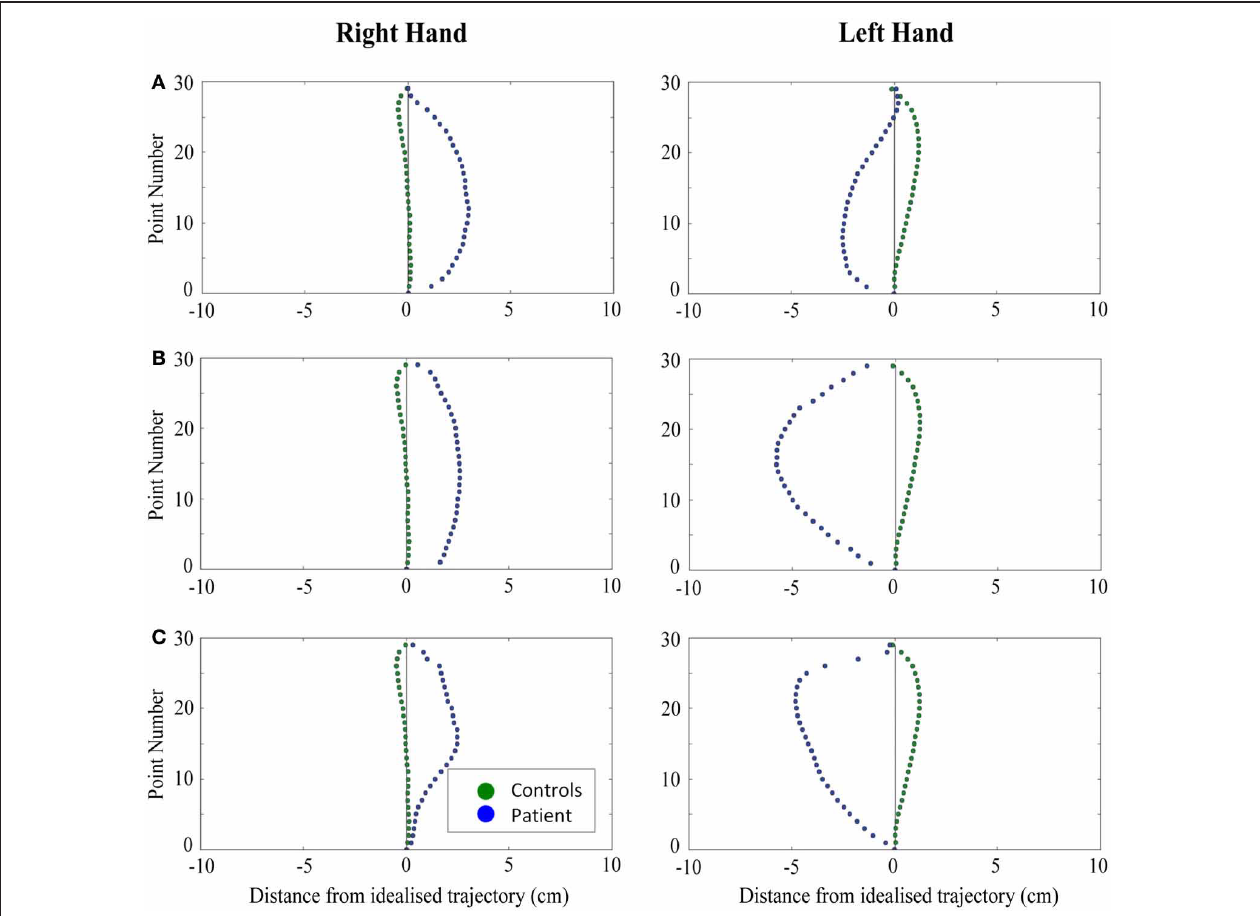
FIGURE 6 | A comparison of standardized reach paths for controls vs. patients—(A): patient RB, (B): patient SS, and (C): patient AP—when grasping contralaterally presented objects with both the right and left hands in Experiment